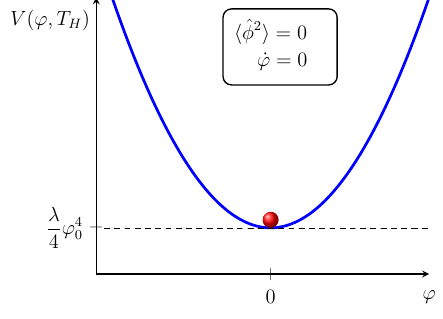
Fig. 1 In the unbroken phase the field is at rest at ϕ = 0 with practi- Fig. 2 Close to symmetry breaking the classical (mean) field ϕ is ˆ φ 2 (cid:11) ∼ almost stationary, but the quantum fluctuations (cid:10) ˆ φ 2 (cid:11) very large since cally no quantum fluctuations, (cid:10) 0. The suppression of the quan- the field is effectively light m ∼ tum fluctuations is caused by the large effective mass making the field heavy with respect to the background curvature